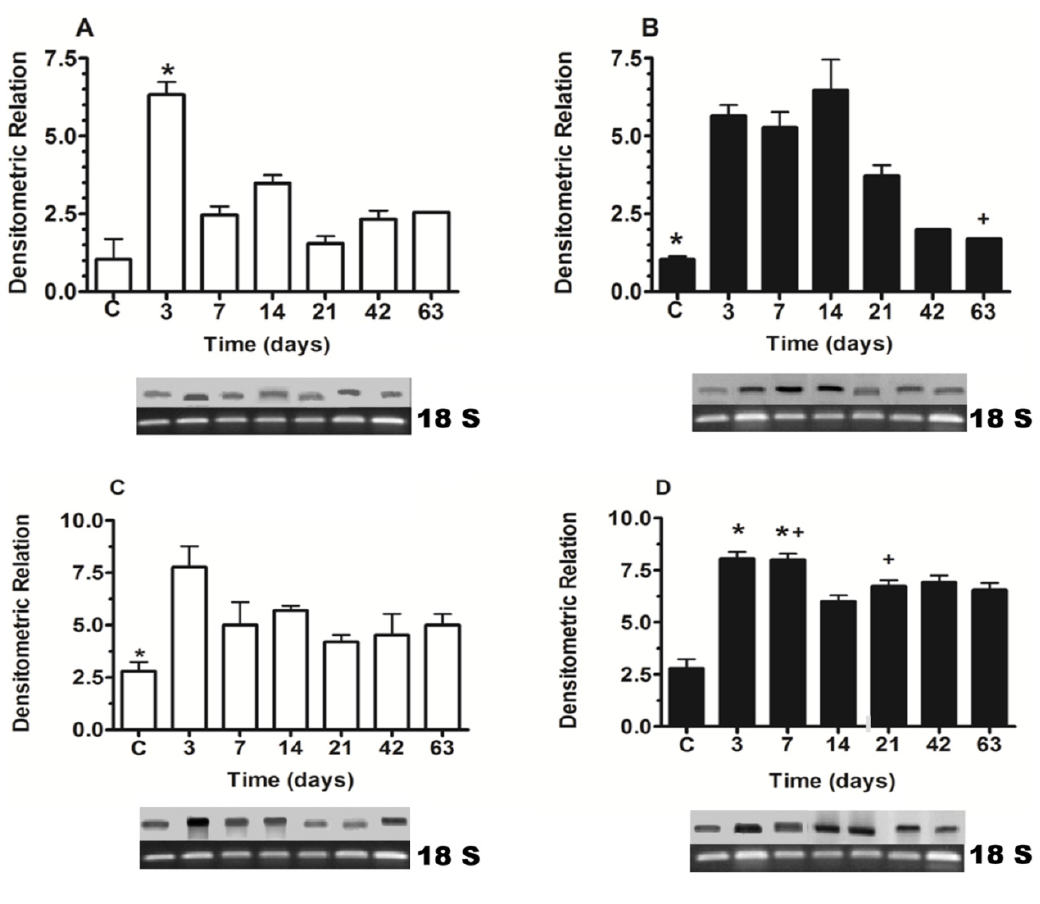
Figure 1. Nkx6.1 ( A , B ) and insulin ( C , D ) gene expression in pancreatectomized animals. ( A , C ) untreated group, ( B , D ) silymarin treated group. ( C ) control group. Each bar represents the mean ± S.E.M. * p < 0.05 versus other times of the same group. + p < 0.05 treated versus untreated animals at the same times. n = 5.